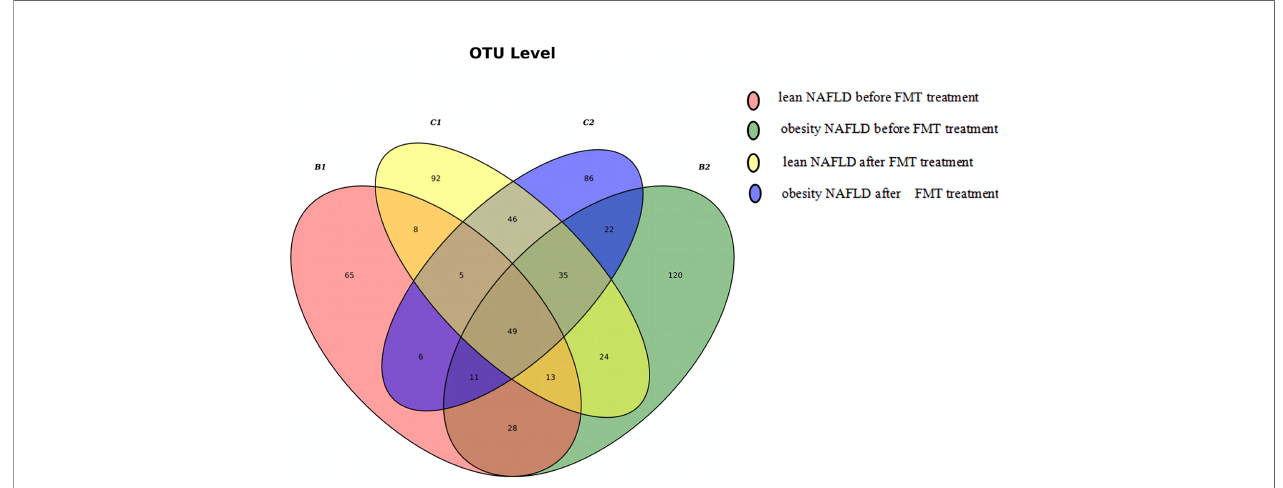
FIGURE 6 | Venn diagram of lean and obese patients with non-alcoholic fatty liver disease (NAFLD) before and after fecal microbiota transplantation (FMT). A total of 654 operational taxonomic units (OTUs) were detected in the four groups, of which 101 OTUs were shared by B1 and B2 and 135 OTUs were shared by C1 and C2. One hundred ninety-seven different OTUs were found between C1 and B1, while 175 OTUs were detected in C2 and